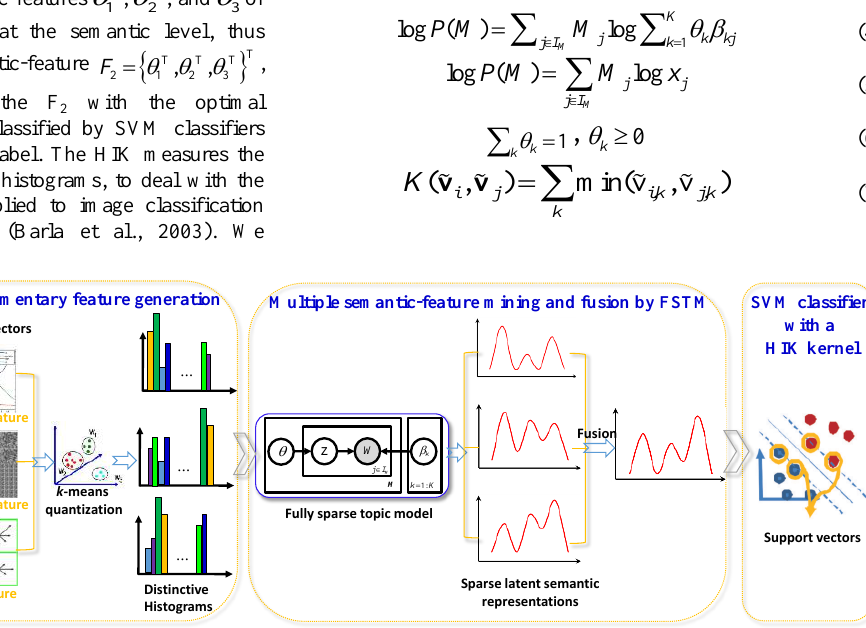
Figure 2. The proposed HSR scene classification based on the